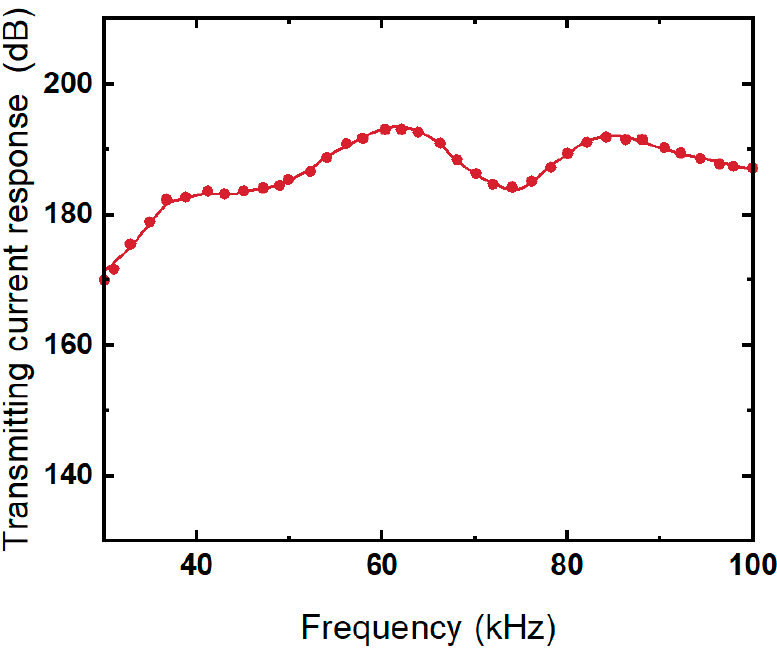
Figure 14. Transmitting current response of the transducer array. Figure 15 shows the receiving sensitivity of the transducer. The maximum receiving sensitivity can reach − 193.2 dB, and the fluctuation is about 10 dB.